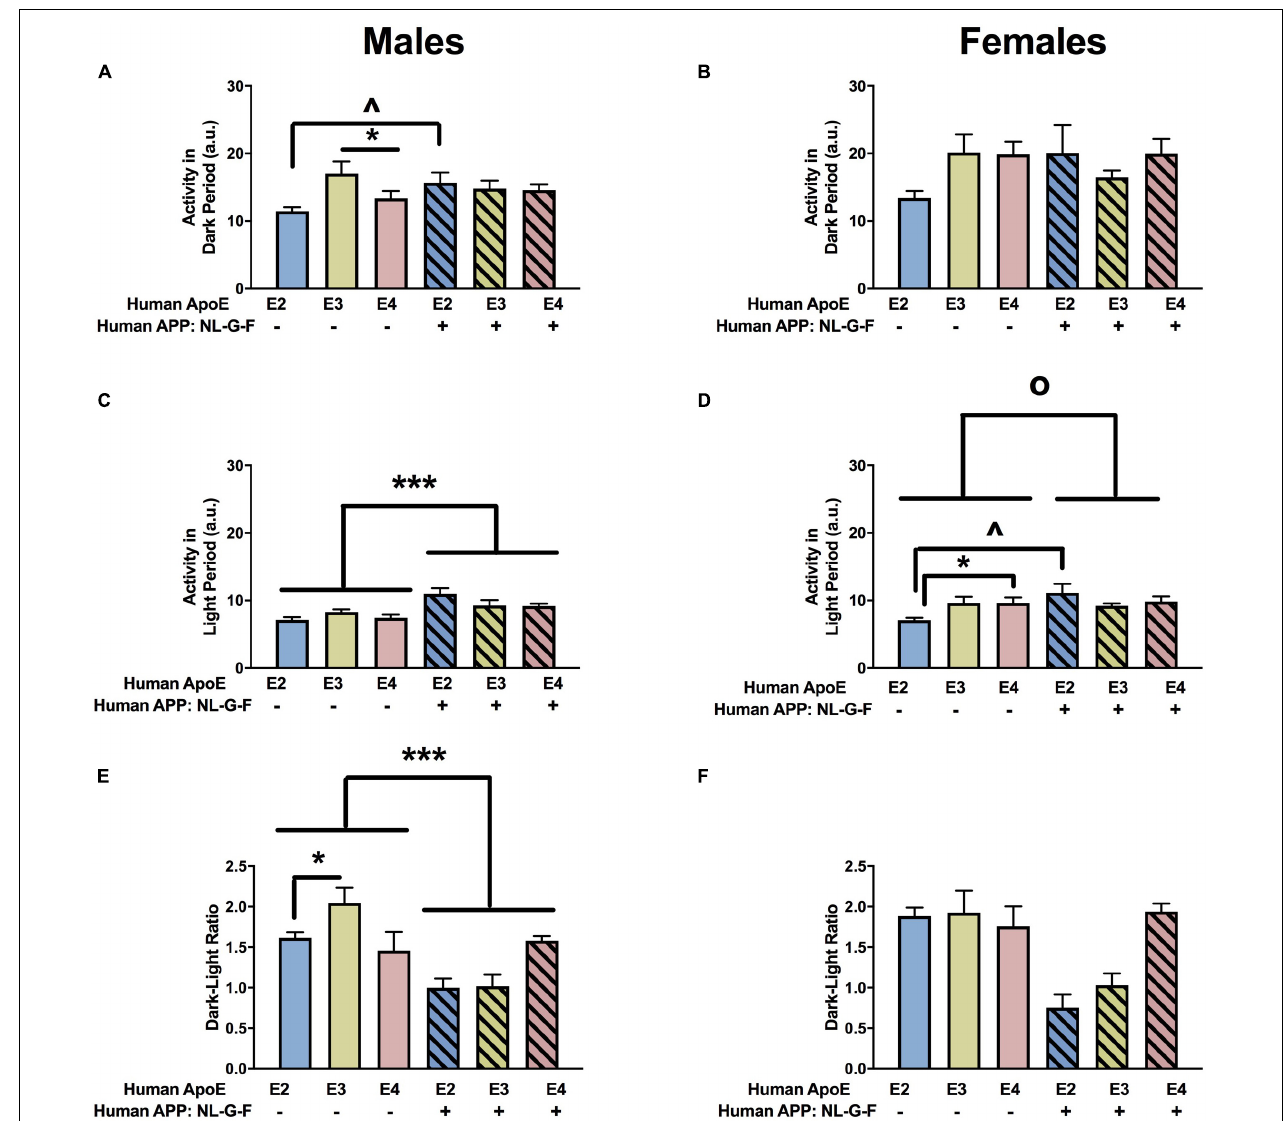
FIGURE 2 | Home cage activity in males (A,C,E) and females (B,D,F) at the 6-month time point. (A) E3 males were more active than E4 males during the dark period. * p < 0.05. In addition, NL-G-F/E2 males were more active than E2 males during the dark period. ∧ p < 0.05. (B) Activity levels of females during the dark period. (C) There was an effect of APP on activity during the light period in males. *** p < 0.001. (D) There was an effect of APP and an APP × APOE interaction for activity during the light in females. o p = 0.043. E2 females were less active than E4 females during the light period. * p < 0.05. Activity levels during the light period were higher in NL-G-F/E2 than E2 females. ∧ p < 0.05. (E) There was an effect of APP and APOE on the dark/light ratio in males. Dark/light ratios were lower in NL-G-F males. *** p < 0.001. In addition, the dark/light ratio was higher in E3 than E2 males. * p < 0.05. (F) Dark/light ratio of females during home cage activity